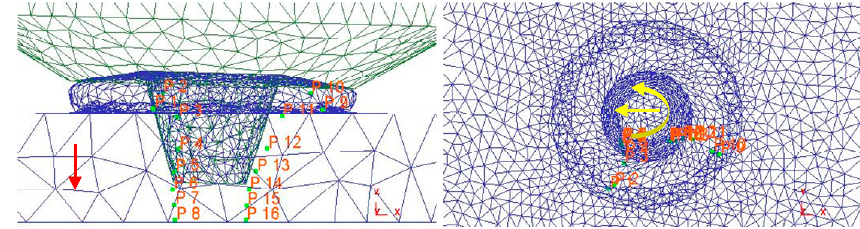
Figure 16. Particle migration during the plunging stage.